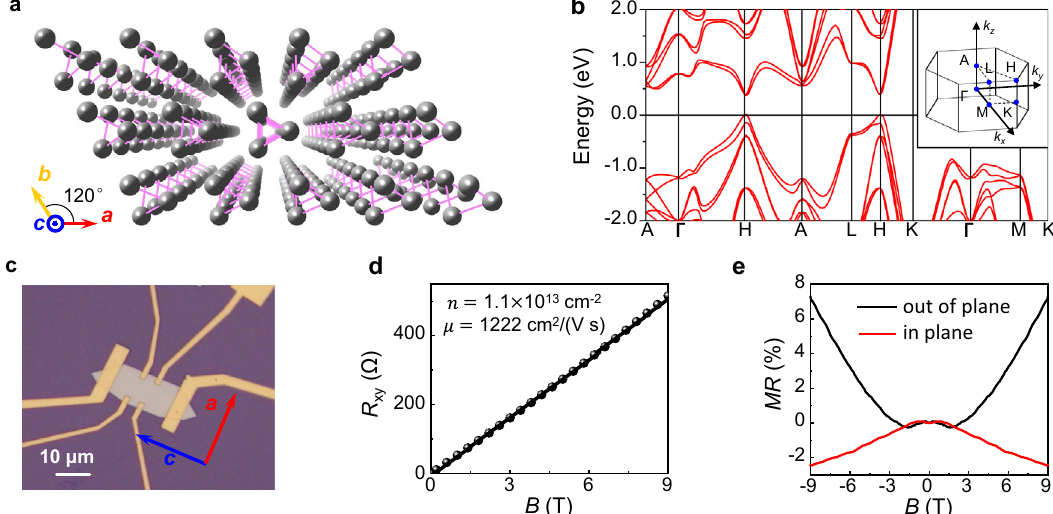
Fig. 1 | Basic characterization of Te fl akes and experimental con fi guration of photocurrent measurement. a The lattice structure of Te. b The energy disper- sion of electronicbandsinTe.Inset shows the corresponding Brillouinzone. c The